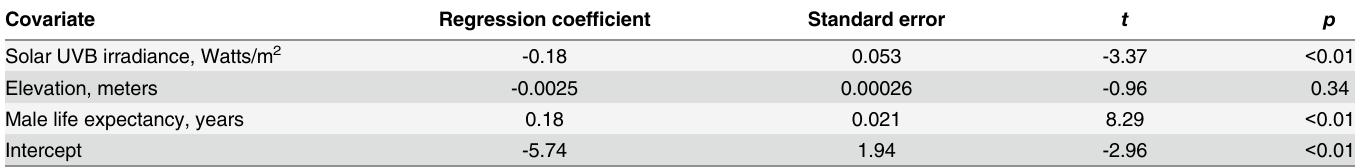
Table 2. Multiple linear regression model for age-standardized leukemia incidence rates according to cloud-adjusted UVB irradiance, males, 158 countries, 2012 ( R 2 = 0.62; p < 0.0001).